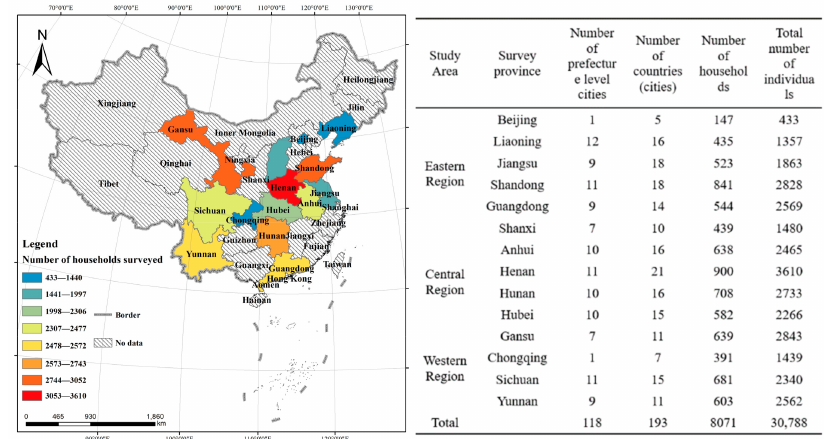
Figure 1. Map of the study area and sample